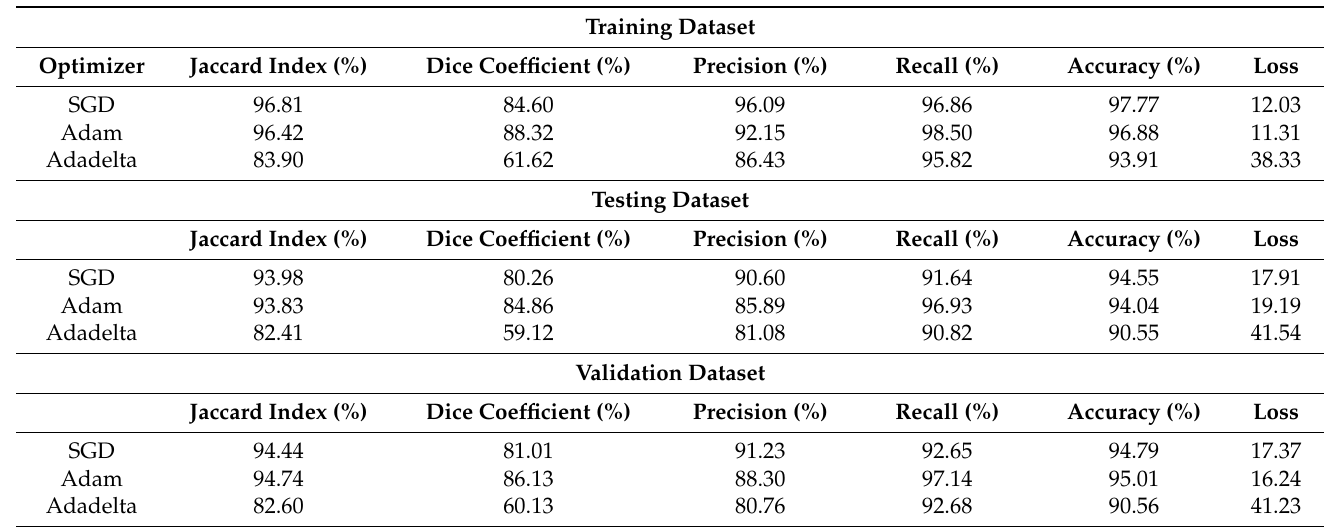
Table 2. Analysis of Different Optimizers with a batch size of 18 and 100